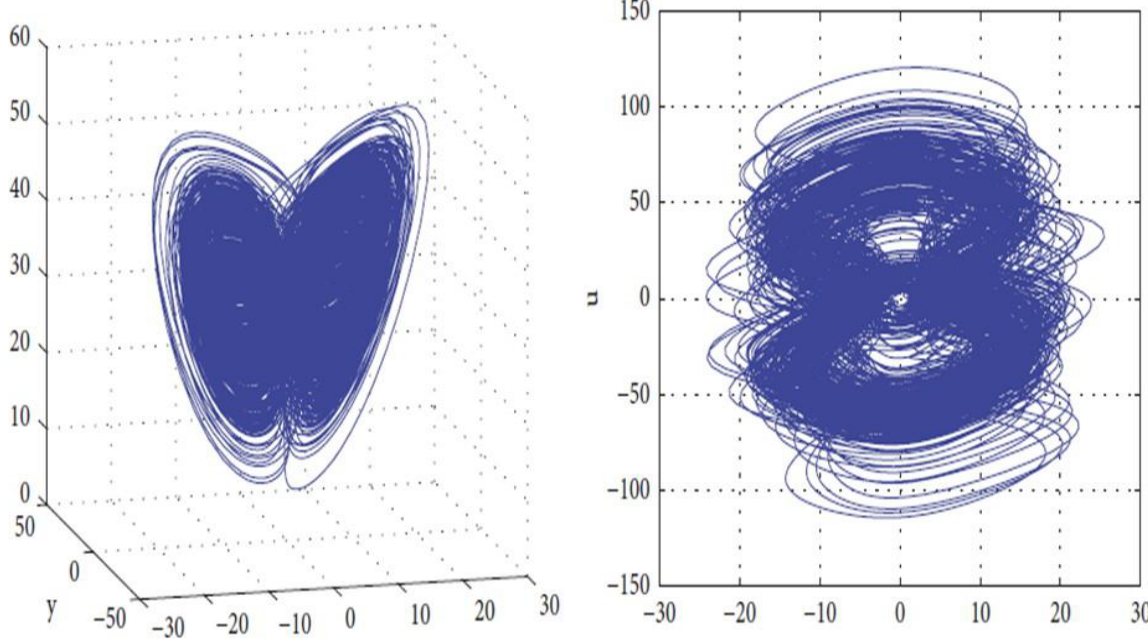
Figure 2. Hyper-Chaotic Attractors.